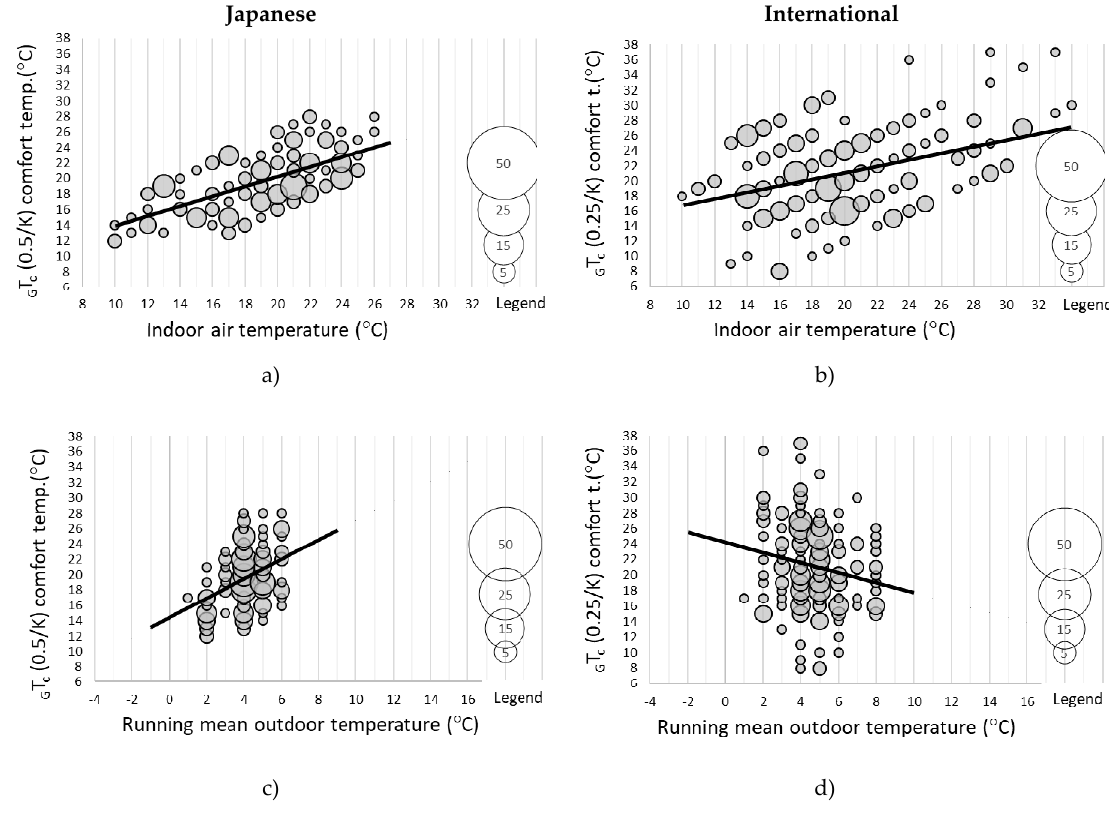
Figure 17. Griffiths comfortable temperature at 0.5/K ( a ) regression with indoor air temperature for Japanese subjects; ( b ) regression with indoor air temperature for non-Japanese subjects; ( c ) regression with a running mean outdoor air temperature for Japanese subjects; ( d ) regression with a running mean outdoor air temperature for non-Japanese subjects.